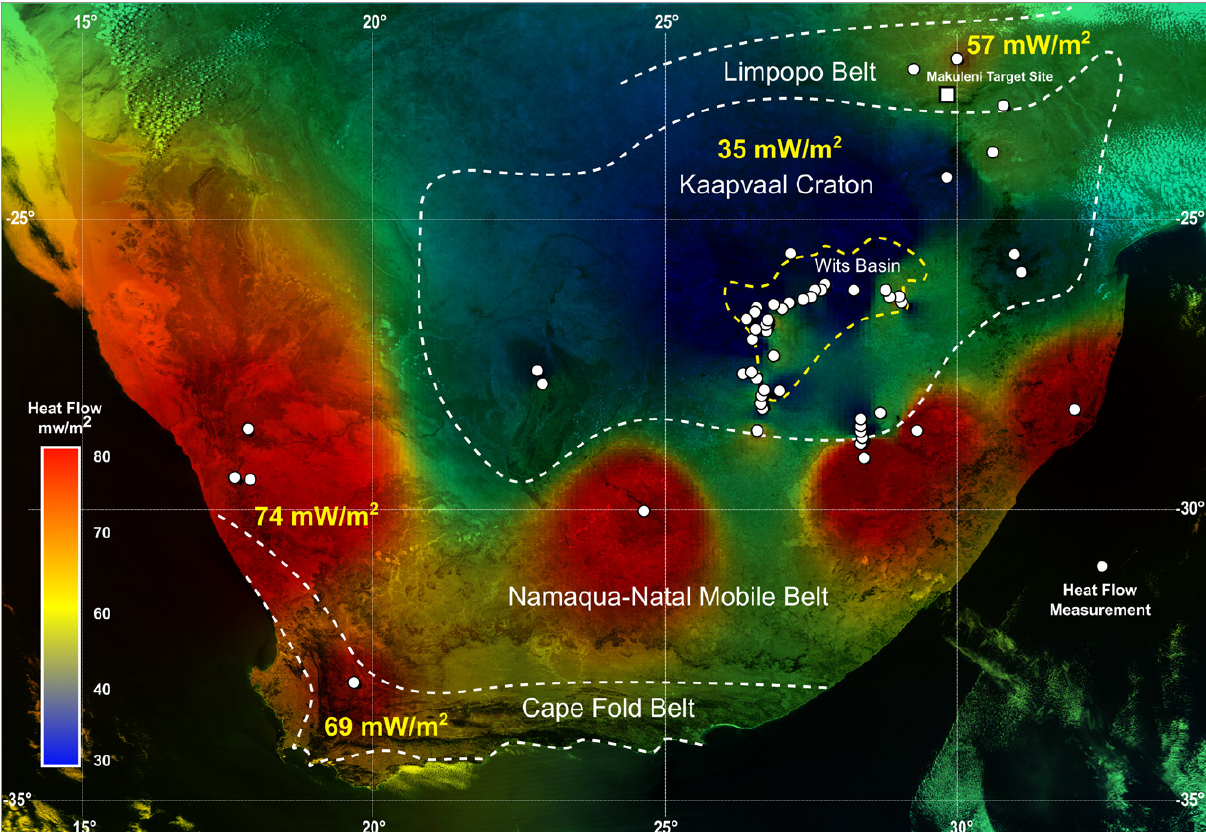
Figure 2: Geothermal potential map produced using available heat flow data created using inverse distance weighting within Quantum GIS. Major tectonic boundaries and geological features are